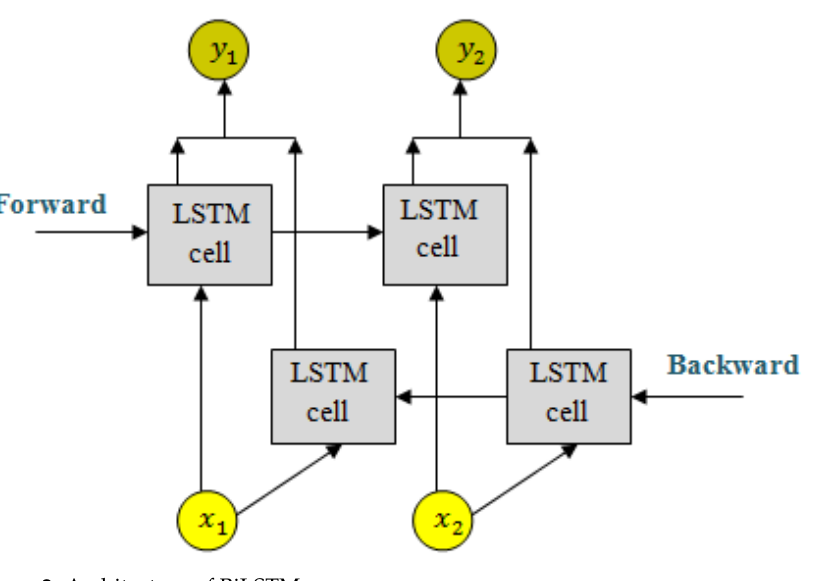
Figure 2. Architecture of